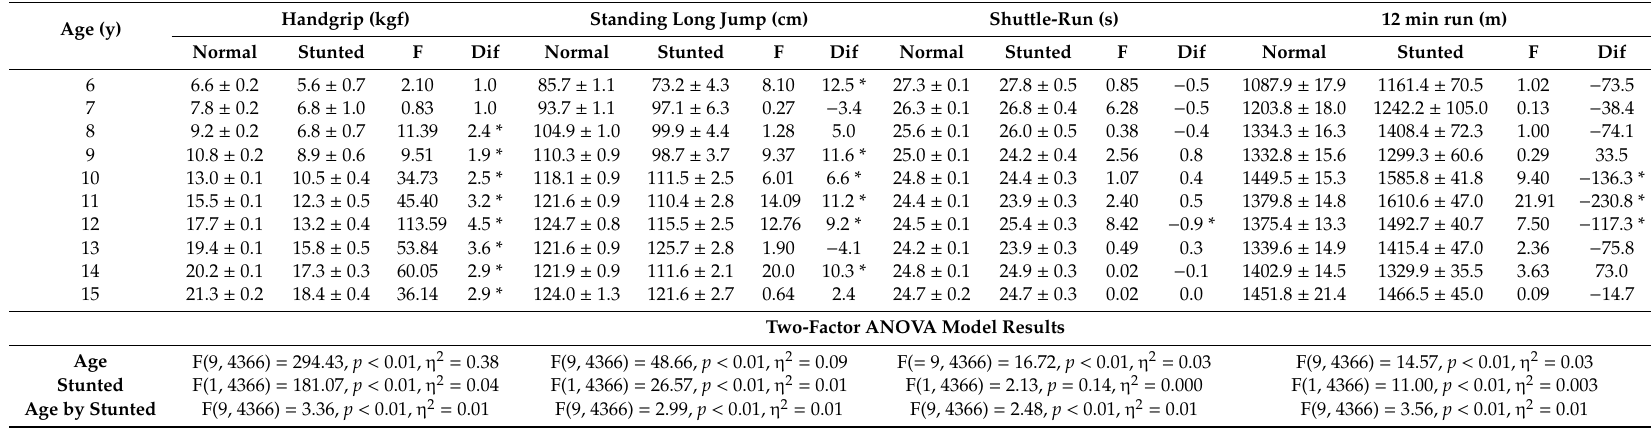
Table 3. Mean di ff erences (Mean ± SD, F tests and Dif) and two-factor ANOVA model results for each physical fitness test between stunted and normal-growth girls. Age (y)